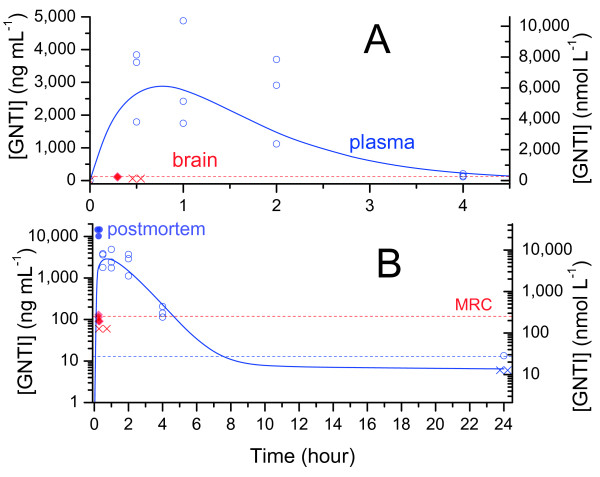
GNTI plasma and brain levels in mice over 24 hours (10 mg kg-1 i.p.). Shaded points represent postmortem samples after 39 mg kg-1. A, linear scale; B, log scale [× = MRC÷2 (estimate for points < MRC)].